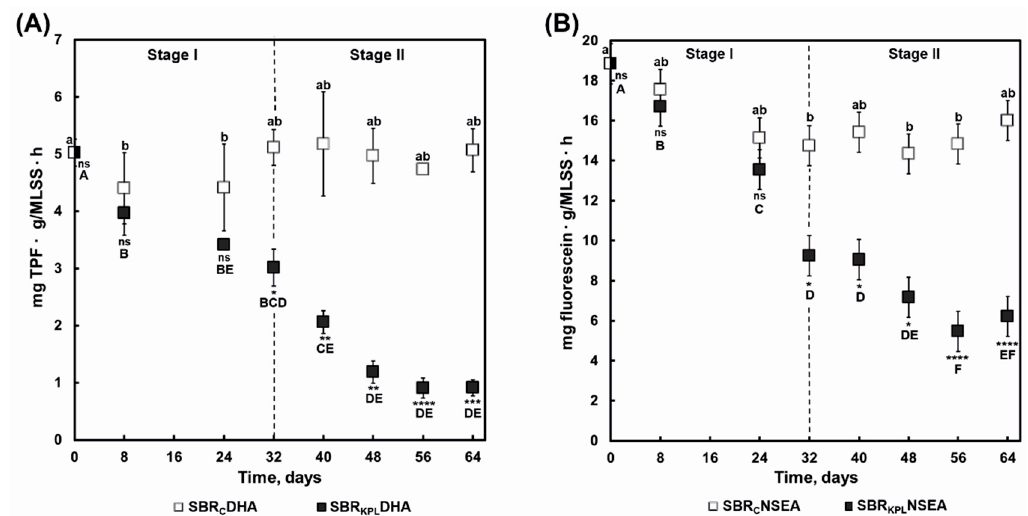
Figure 5. The changes in activity of dehydrogenases ( A ) and nonspecific esterases ( B ) in the SBR C and SBR KPL during 64 days of wastewater treatment.